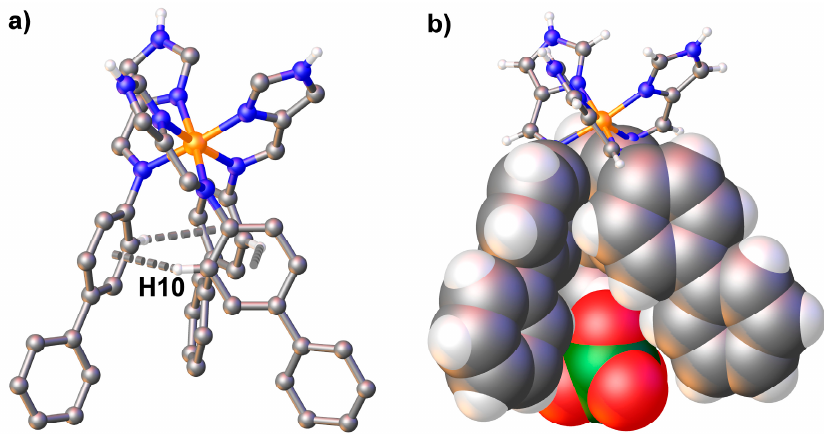
Figure 3. View of ( a ) the intramolecular C–H ··· π contacts in 1 and ( b ) spacefill diagram showing the perchlorate anion in the biphenyl pocket.